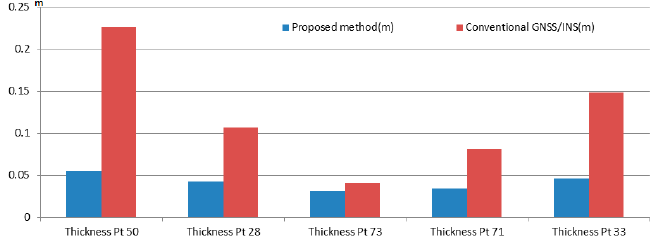
Figure 18. Thickness assessment of Lidar points for five sample arrows in Figure 16a.